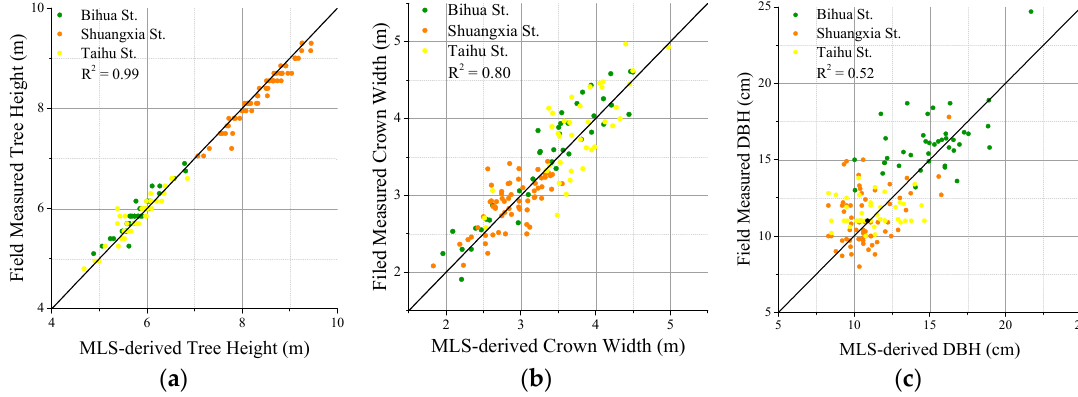
Figure 13. Comparison between MLS-derived morphological parameters and field measured morphological parameters. ( a ) Tree height; ( b ) Crown width; ( c ) DBH.